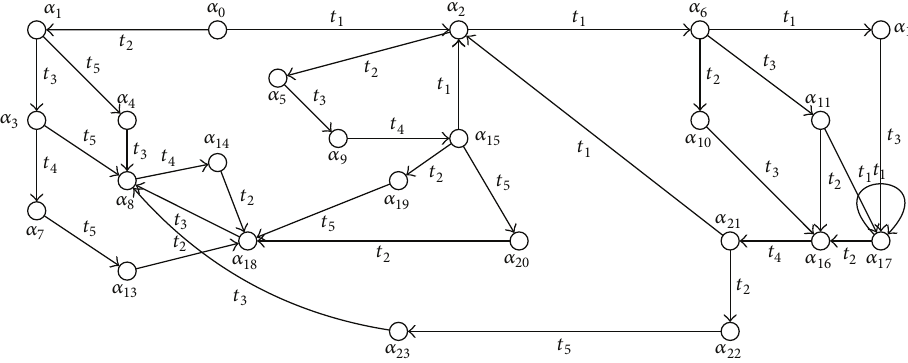
Figure 18: The state class graph of the TPN presented at Figure 17.